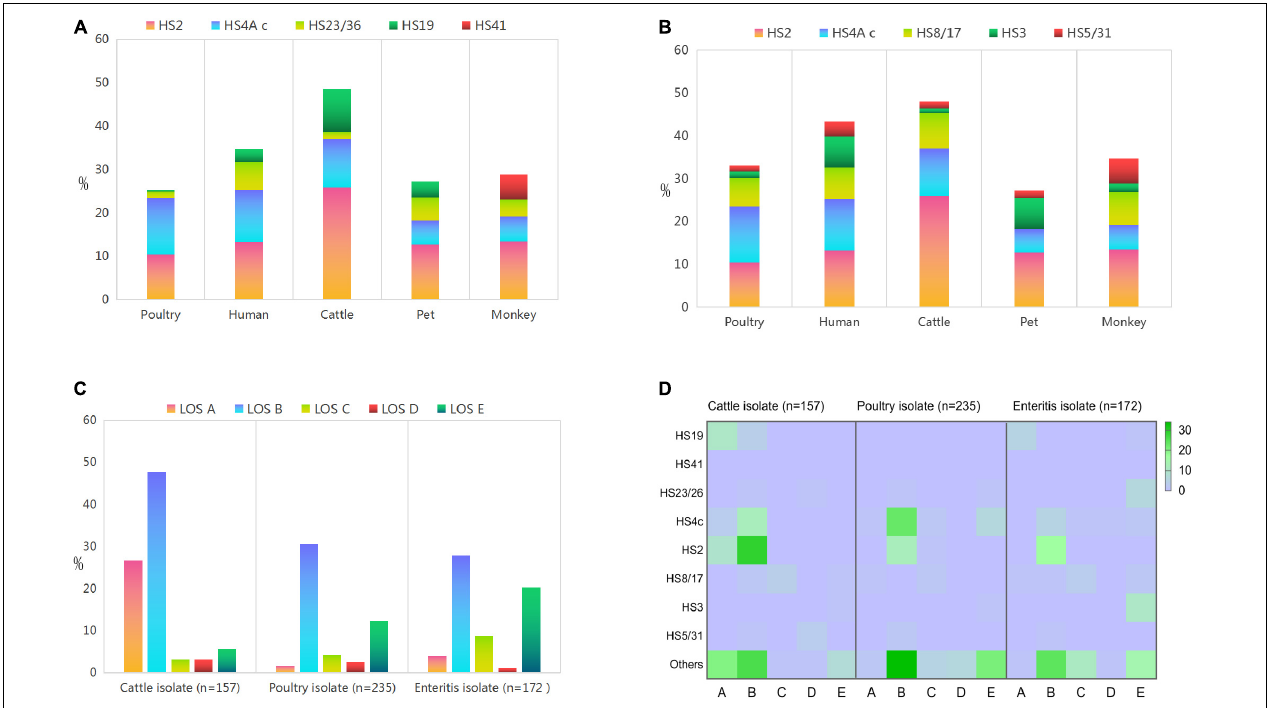
FIGURE 2 | Proportional representations of the disease related capsular genotypes and lipooligosaccharide classes among Campylobacter jejuni isolates from different sources. (A) GBS associated capsular genotype. (B) Enteritis associated capsular genotype. (C) Lipooligosaccharide classes. (D) Heat map demonstrates the correlation between lipooligosaccharide class and disease associated capsular